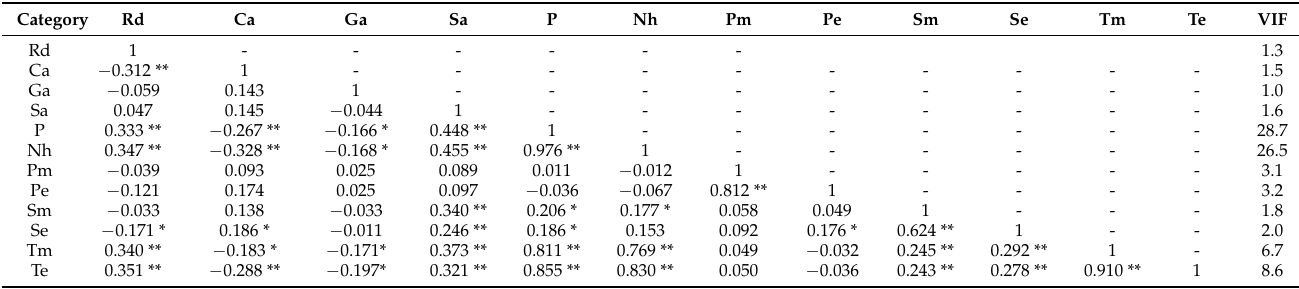
Table 6. Correlation coefficients and variance inflation factors (VIFs) among variables potentially influencing forest loss. See Table 3 for variable abbreviations.